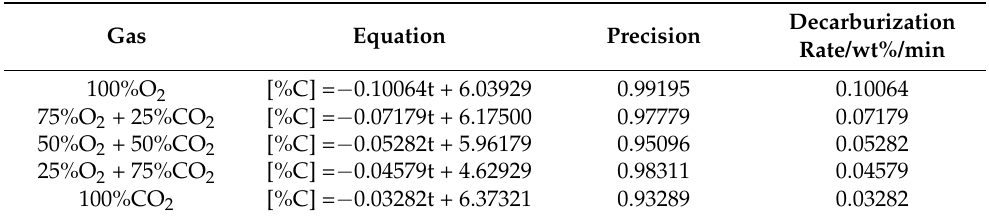
Figure 6. Curve fitting for the variation in carbon content when blowing different CO 2 ‐ O 2 mixtures. Table 6. Fitting equations for the carbon content variation with time by blowing different CO 2 -O 2